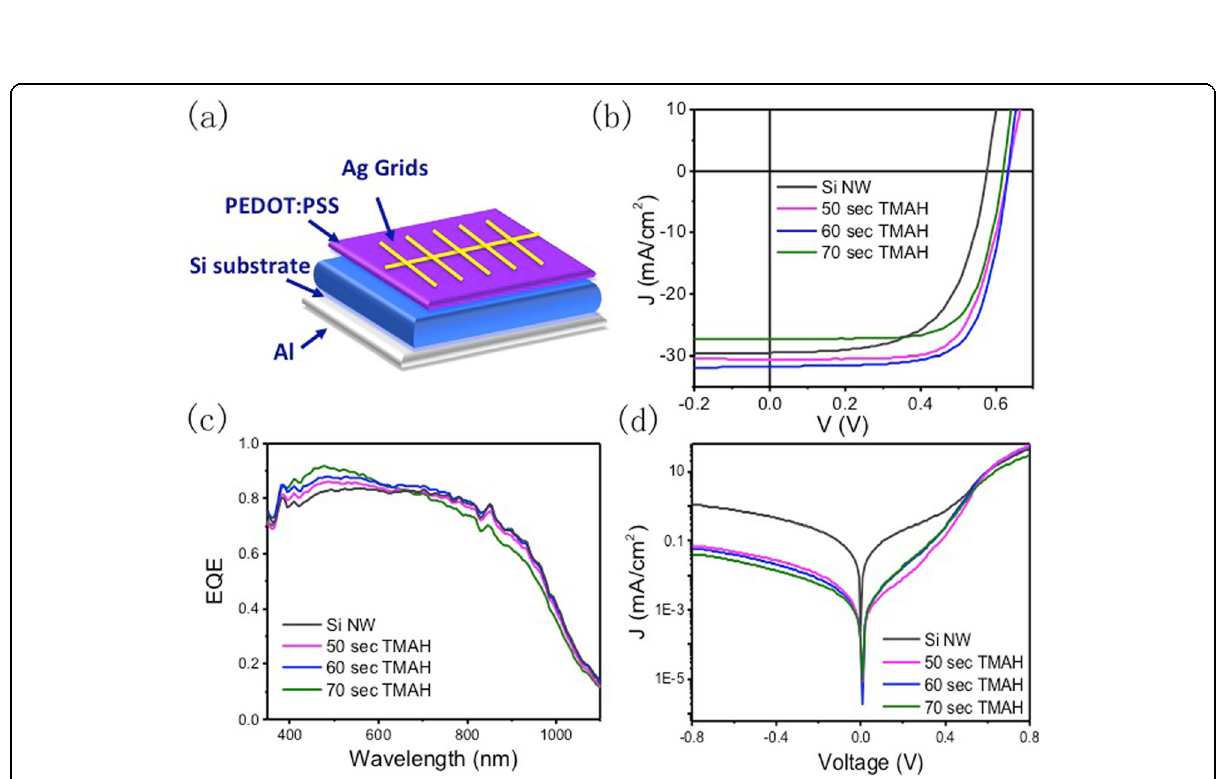
Fig. 4 Device performance of the hybrid Si/PEDOT:PSS solar cell: a device structure of PEDOT:PSS/Si hybrid solar cell, b current density-voltage (J-V) curves of devices based on different nanostructured Si substrate, c external quantum efficiency spectra, and d J-V curves under